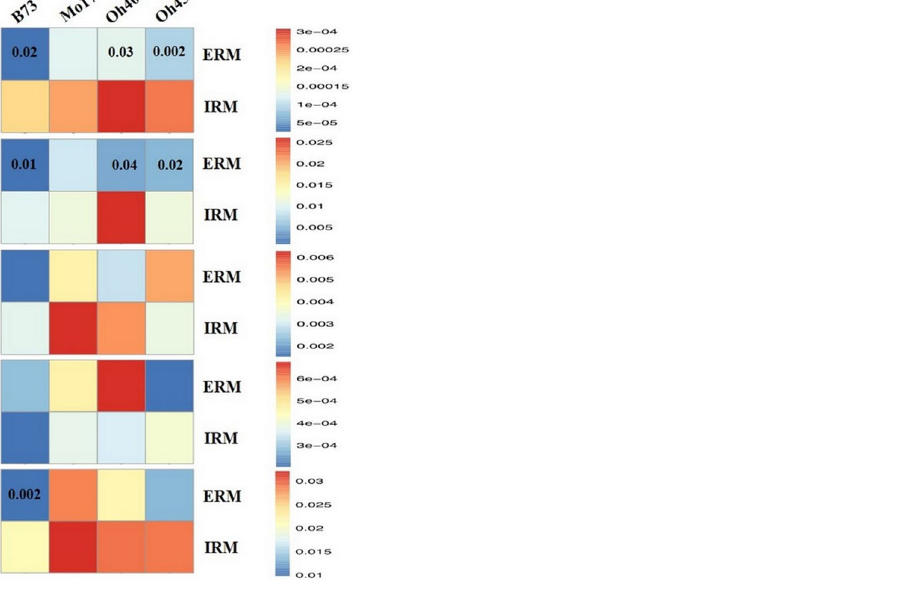
Figure 4. Heat map based on qRT-PCR quantification of expression levels of Rhizoglomus irregulare phosphate transporters ( RiPT ) in extraradical (ERM) and intraradical (IRM) mycelium under low phosphorus availability (0.47 mg kg −1 ). Mean gene expression was scaled independently for each phosphate transporter from blue (minimum) to red (maximum). For each RiPT and maize line, significant differences between values obtained from the two mycelial types are indicated by the relevant P value. Expression levels were normalized against the ef1-α